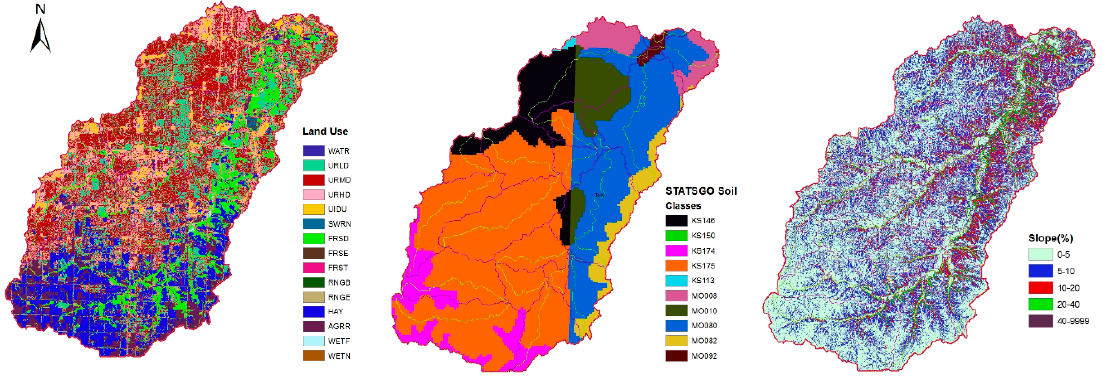
Figure 4. Reclassified land use, soil and slop data used in the HRU delineation.